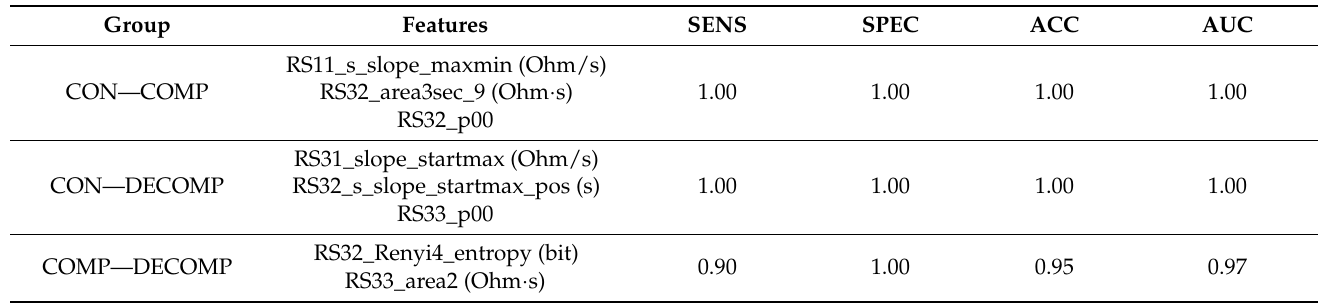
Table 2. Percentage classification rate of e-nose features. The optimal parameter set (consisting of either double or triple sets) is shown for each group